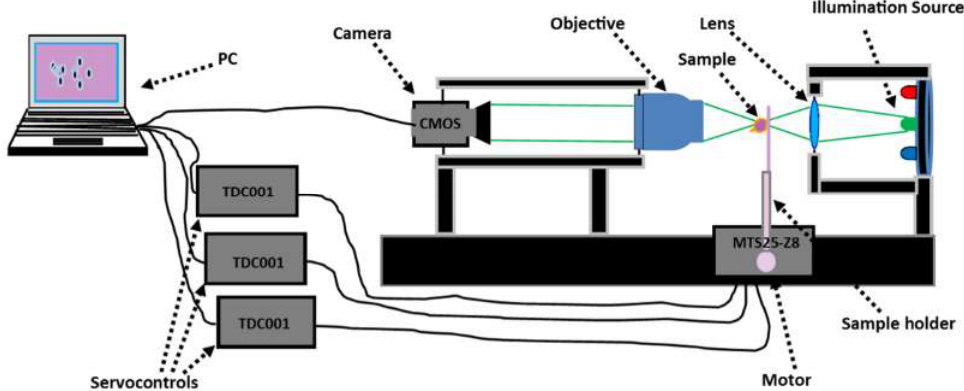
Figure 1. Microscope constructed for brightfield image recording.